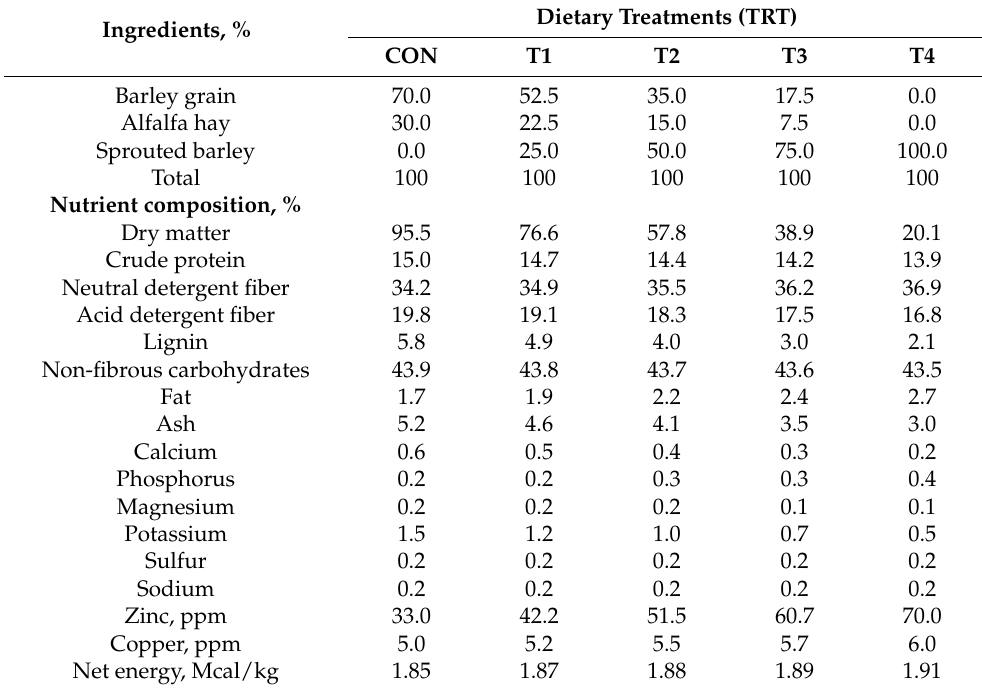
Table 1. All lambs were fed twice daily (08:00 and 14:00) and had ad libitum access to feed and water throughout the study period. Table 1. Ingredients and nutrient analysis as a % on a dry matter basis of dietary treatments 1 . Ingredients,